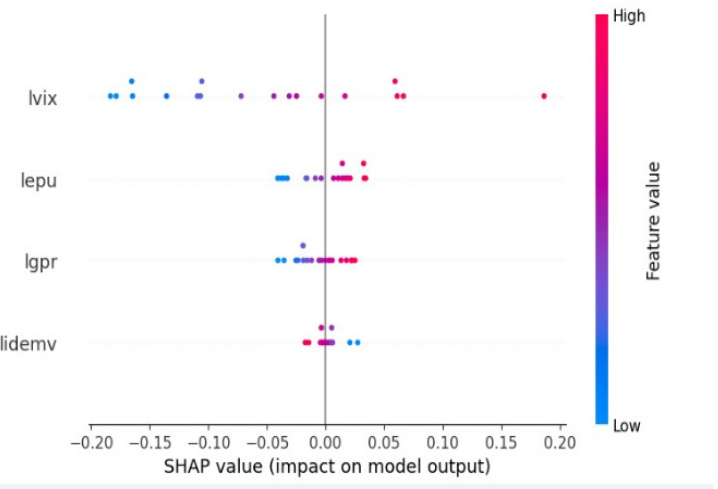
Figure 12. Feature importance before the pandemic—XGBoost model (Weekly frequency).